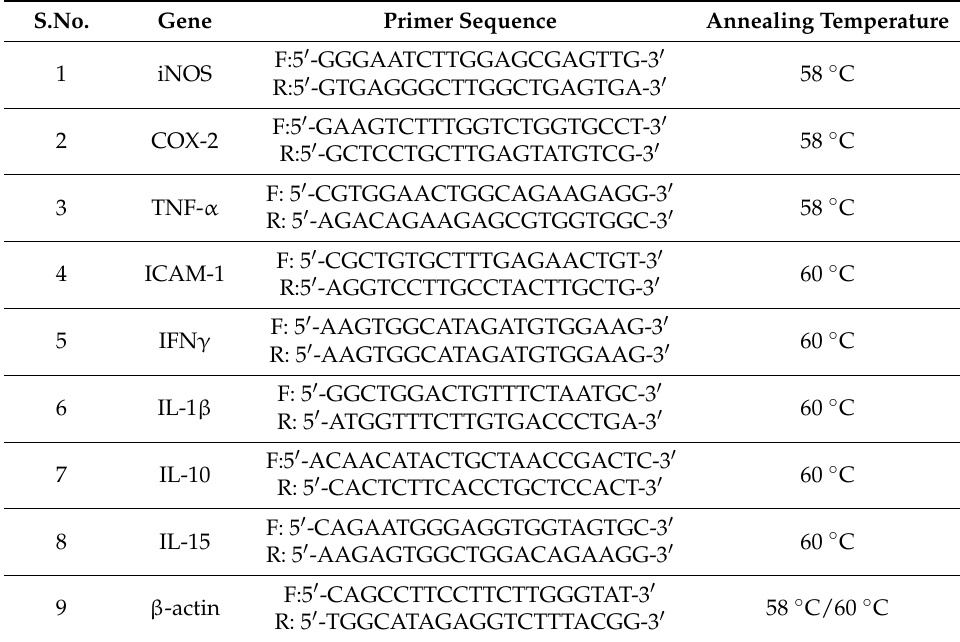
Table 2. The list of